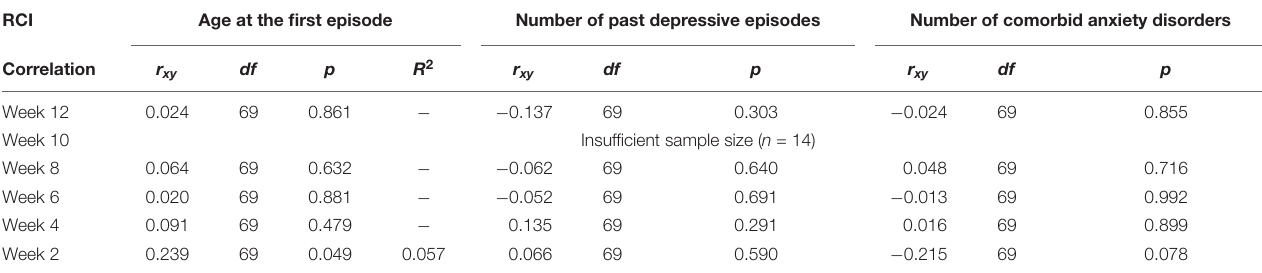
TABLE 8 | Pearson’s correlation, degrees of freedom, p -value, and effect size of the different quantitative variables of severity. RCI Age at the first episode Number of past depressive episodes Number of comorbid anxiety disorders